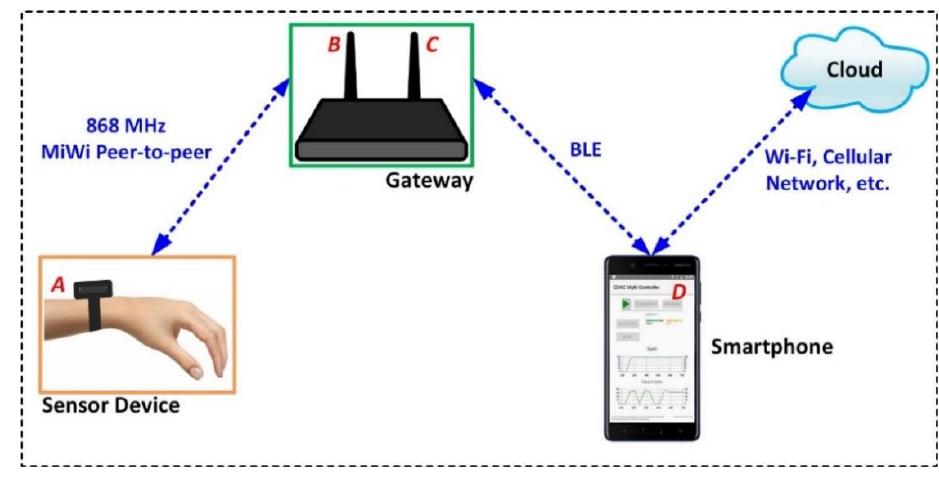
Figure 2. System hardware architecture.